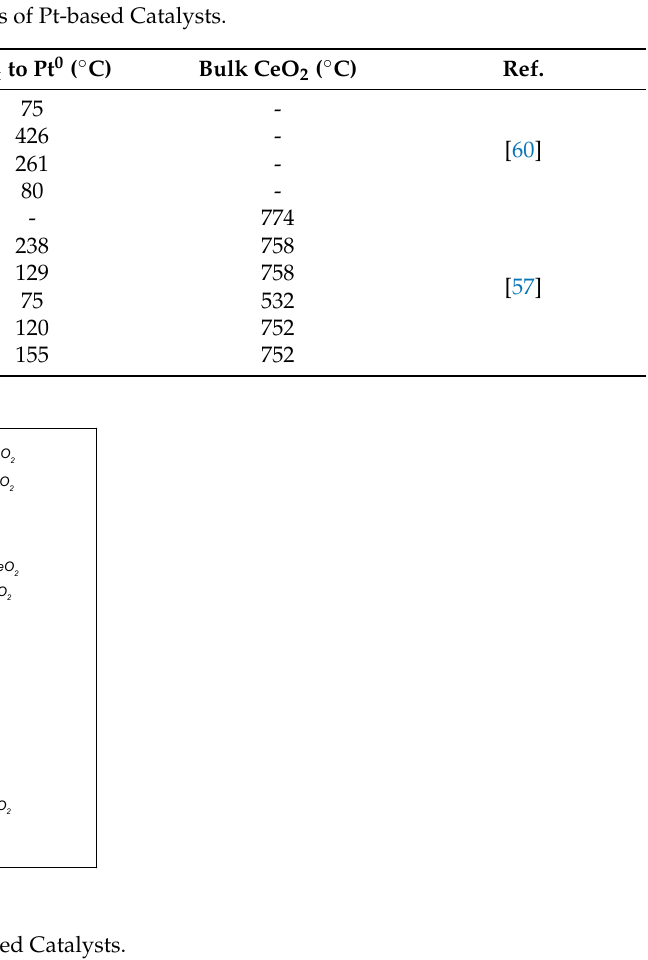
Table 12. Reduction characteristics of Pt-based Catalysts.